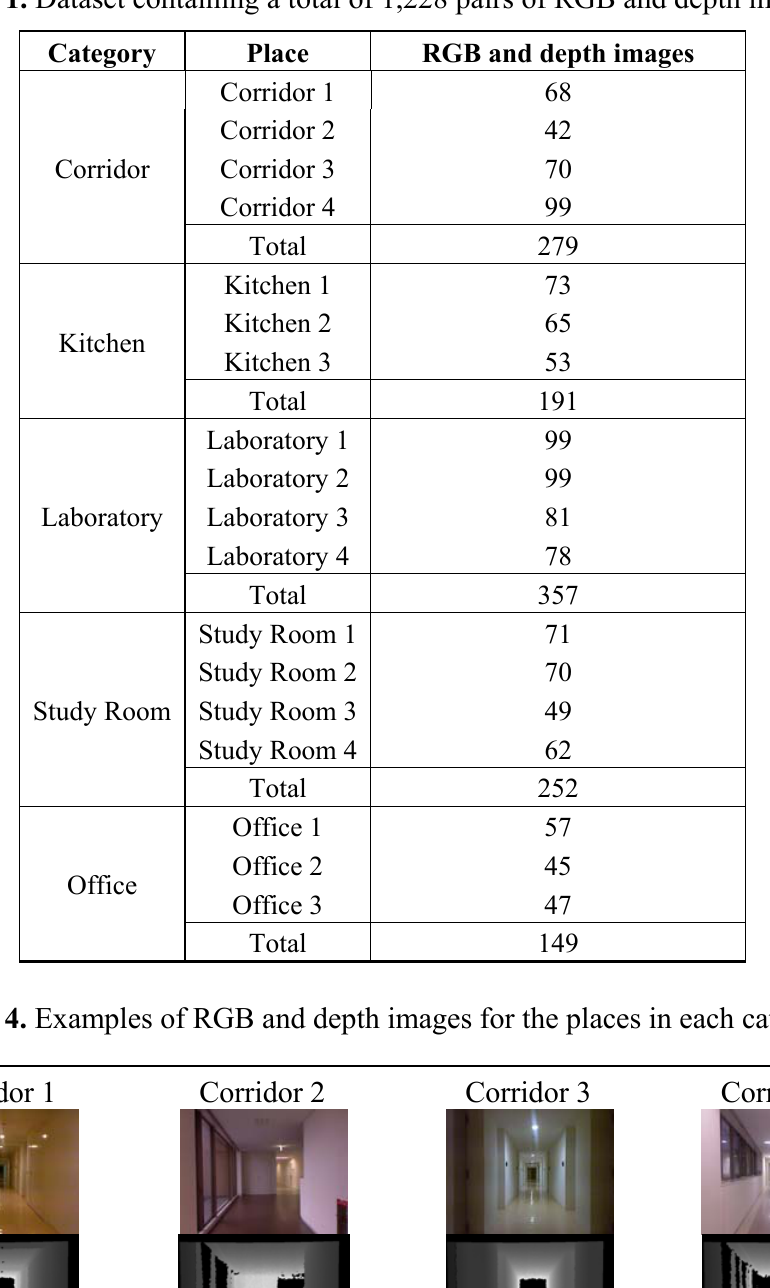
Table 1. Dataset containing a total of 1,228 pairs of RGB and depth images.